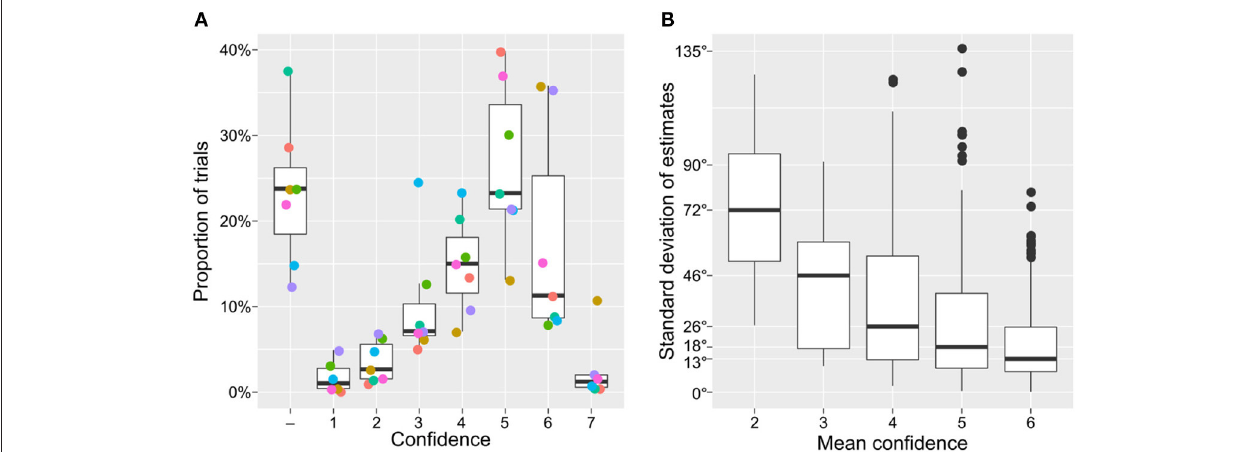
FIGURE 4 | Distribution of confidence reports and observer consistency. (A) The proportion of confidence reports, circle colors denote individual observers. (B) The standard deviation of estimates as a function of average reported confidence level (only paintings with estimates from at least three different participants were included in the analysis). Higher confidence resulted in estimates that were more consistent across observers.